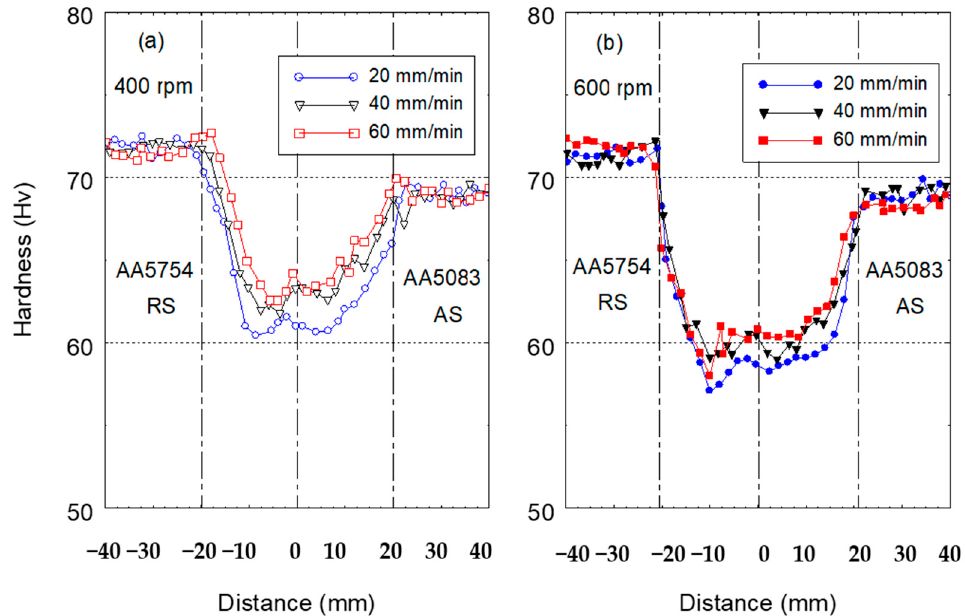
Figure 9. Hardness values along FSWed joints AA5083/AA5754 at travel speeds of 20, 40 and 60 mm/min and rotation speeds of ( a ) 400 rpm and ( b ) 600 rpm.